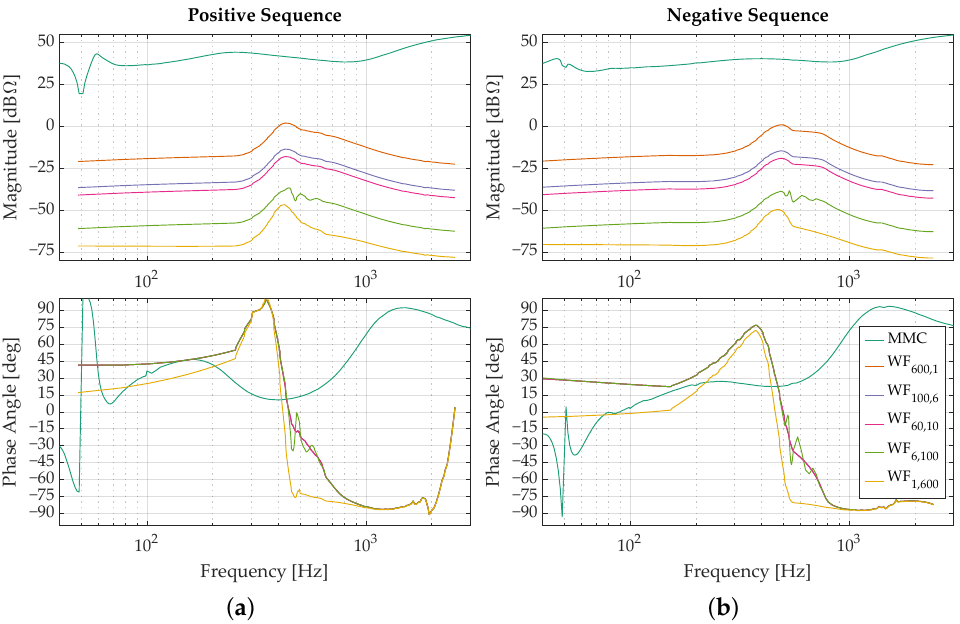
Figure 28. Bode plots of grid-forming MMC and offshore wind farm impedance ratio for different wind farm grid